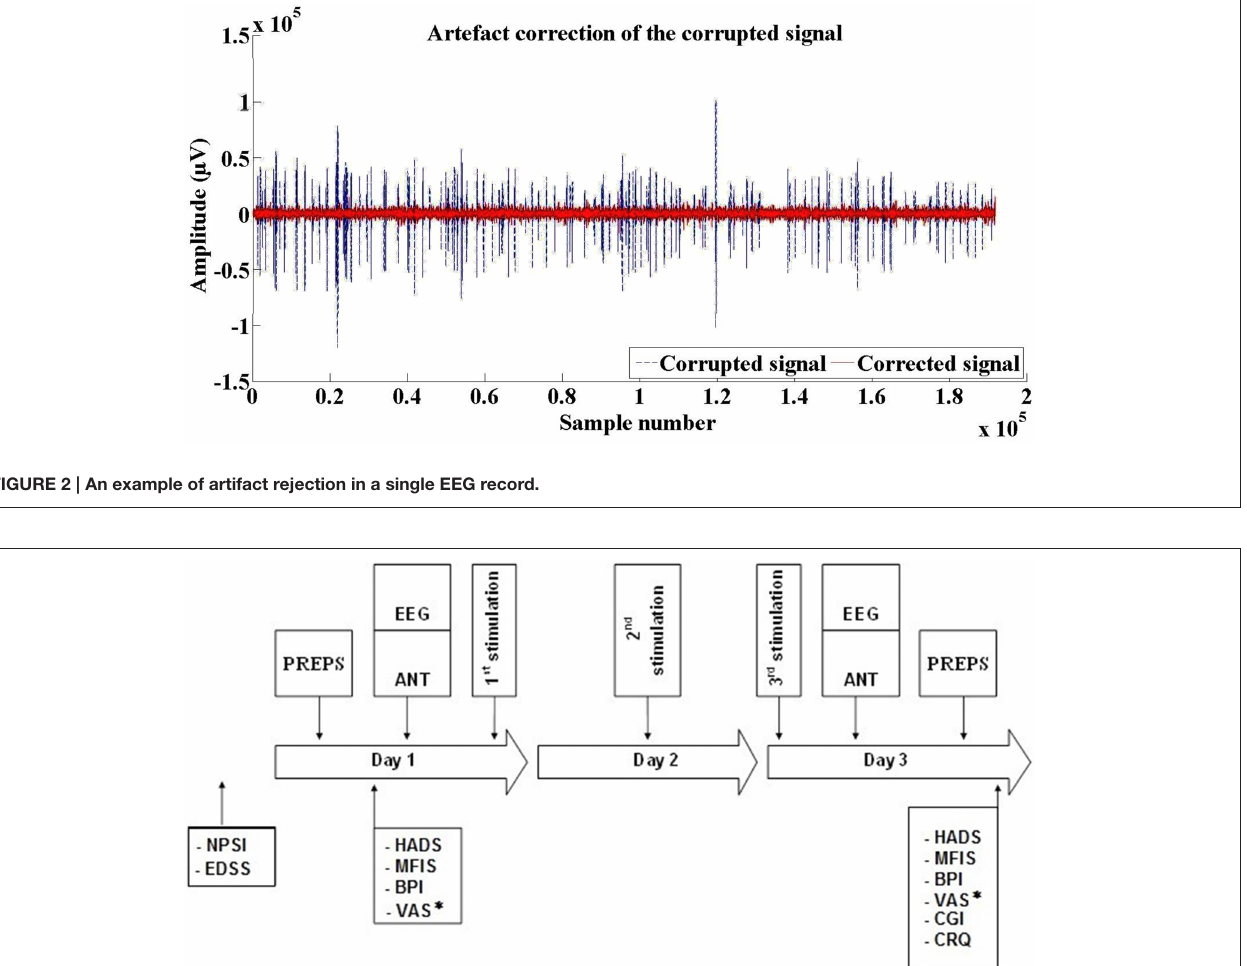
FIGURE 3 | Schematic diagram of the experimental protocol. Two tDCS blocks, each consisting of 3 consecutive daily stimulations of either sham tDCS or active tDCS (randomized order); held apart by a 3-week interval.ANT, Attention Network Test; BPI, Brief Pain Inventory; CGI, Clinical Global Impression; CRQ, Comfort Rating Questionnaire; EEG, recording at Fpz and Pz during ANT; EDSS, Expanded Disability Status Scale; HADS, Hospital Anxiety and Depression Scale; MFIS, Modified Fatigue Impact Scale; NPSI, Neuropathic Pain Symptoms Inventory; PREPs, Pain Related Evoked Potentials; VAS * , Visual Analog Scale for pain assessed 7 days prior to the first stimulation session (D1) and 7 days after the last stimulation session (D3) of each